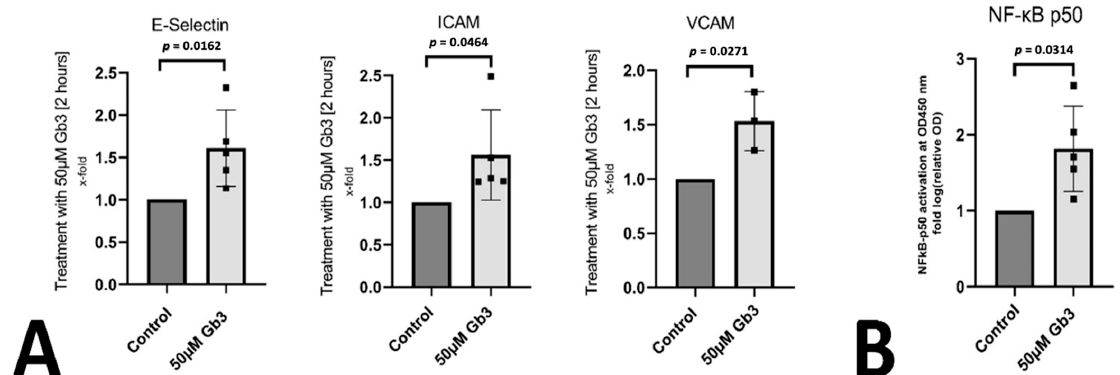
Figure 2. Gb3 induces a proinflammatory phenotype in endothelial cells: ( A ) human endothelial cells were stimulated with Gb3 and E-selectin, ICAM, and VCAM was determined by qPCR as indicated in the methods. Mean ± standard deviation is depicted with p ≤ 0.05 considered as significant. ( B ) p50 protein translocation after Gb3 stimulation was determined in nuclei of endothelial cells using a specific ELISA. Mean ± standard deviation is depicted with p ≤ 0.05 considered as significant.